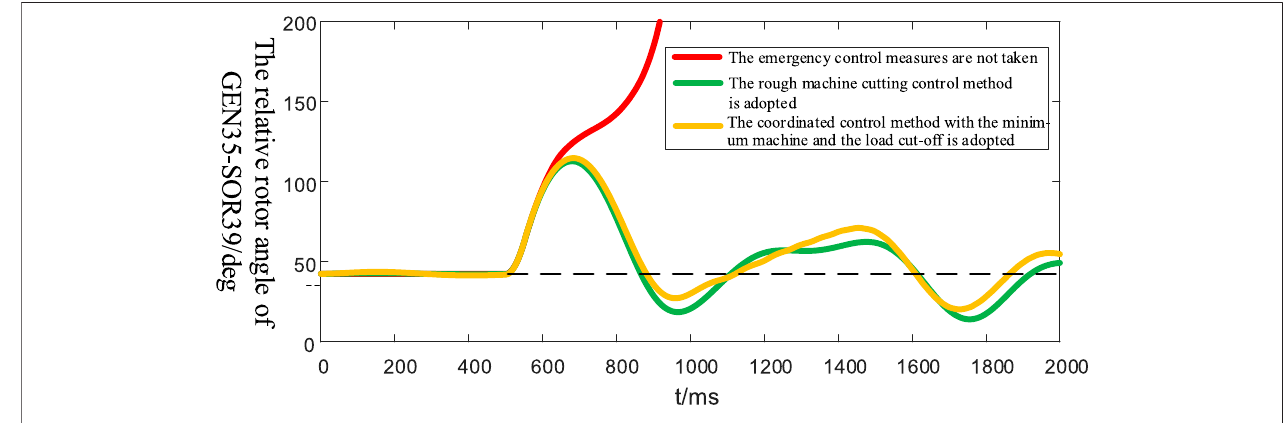
FIGURE 15 | Relative angle curve of GEN_35-SOR_39 under different control measures.